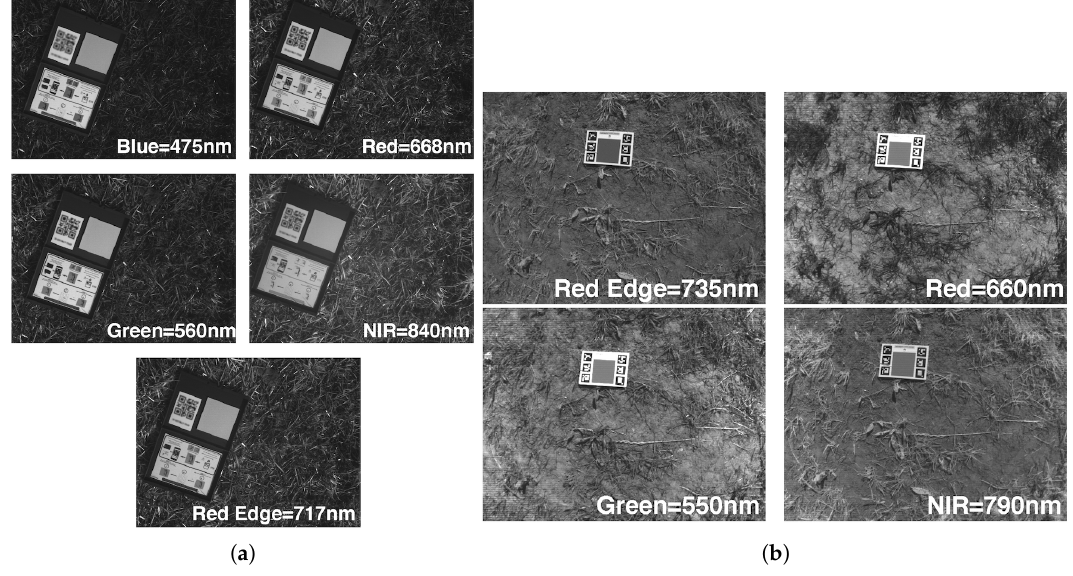
Figure 7. ( a ) RedEdge-M radiometric calibration pattern ( b ) Sequoia calibration pattern for all four